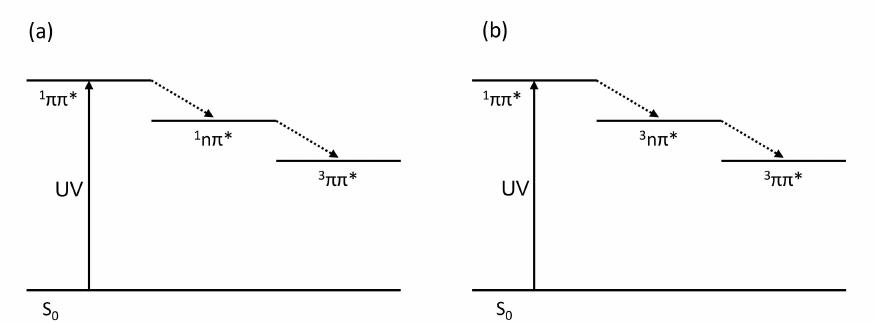
Figure 2. Possible non-radiative decay (NRD) routes following the absorption of UV light. ( a ) Internal conversion from the 1 ππ * to the 1 n π * state followed by intersystem crossing to the 3 ππ * state. ( b ) Direct intersystem crossing from the 1 ππ * to the 3 n π * state followed by internal conversion to the 3 ππ *